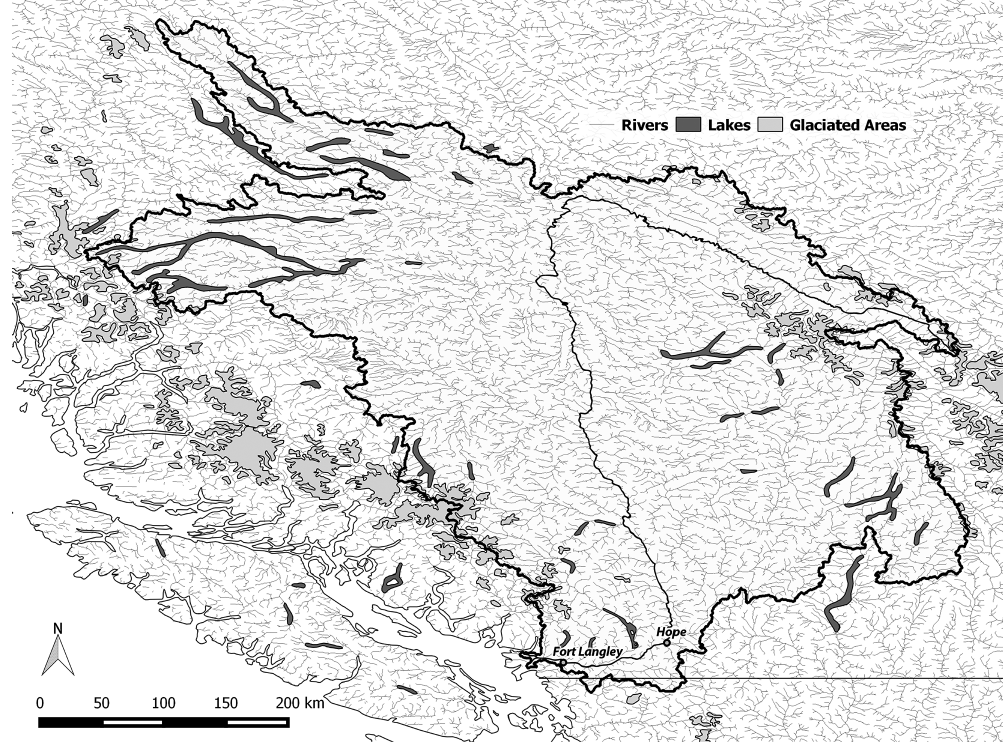
Figure 1. The Fraser River basin, highlighting lakes (natural and man-made; dark grey) and glaciated areas (light grey). Samples were collected at Fort Langley and discharge data (from Environment Canada) are from Hope. River contours and watershed boundaries provided by HydroSHEDS; lake and glacier outlines are derived from the Digital Chart of the World and accessed through Natural Earth Data